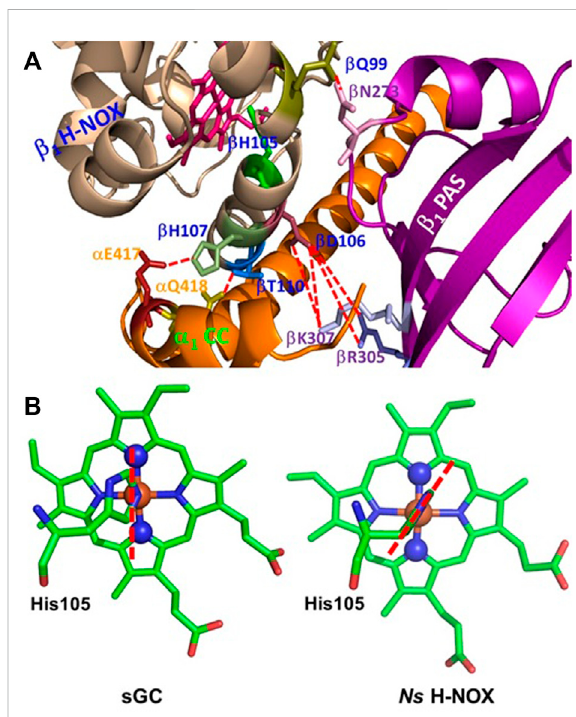
FIGURE 5 Structural elements which may determine theproximal strain in sGC. (A) Possible H-bonding or polar interactions between the residues on or near helix F in ß 1 H-NOX domain and residues from other α 1 and ß 1 domains, represented using red dashed lines. The proximal ligand to the heme, His105, is located on helix F, and these H-bonding or polar interactions may modulate the length and strength of Fe-His105 bond, therefore contributing to the proximal stain of heme. (B) In sGC, His105 imidazole ring orients approximately along the line connecting the nitrogen atoms of pyrrole rings B and D of the heme, adopting an “ eclipsed ” conformation (PDB 6JT0). On the other hand, in Ns H-NOX, a bacterial analogue of sGC, the imidazole ring of the proximal ligand His105 is in a “ staggered ” conformation, orientated more along the line connecting β and δ methine carbons of the heme (PDB 2Y10). The heme with a staggered proximal histidine ligand usually has stronger af fi nities for the gaseous